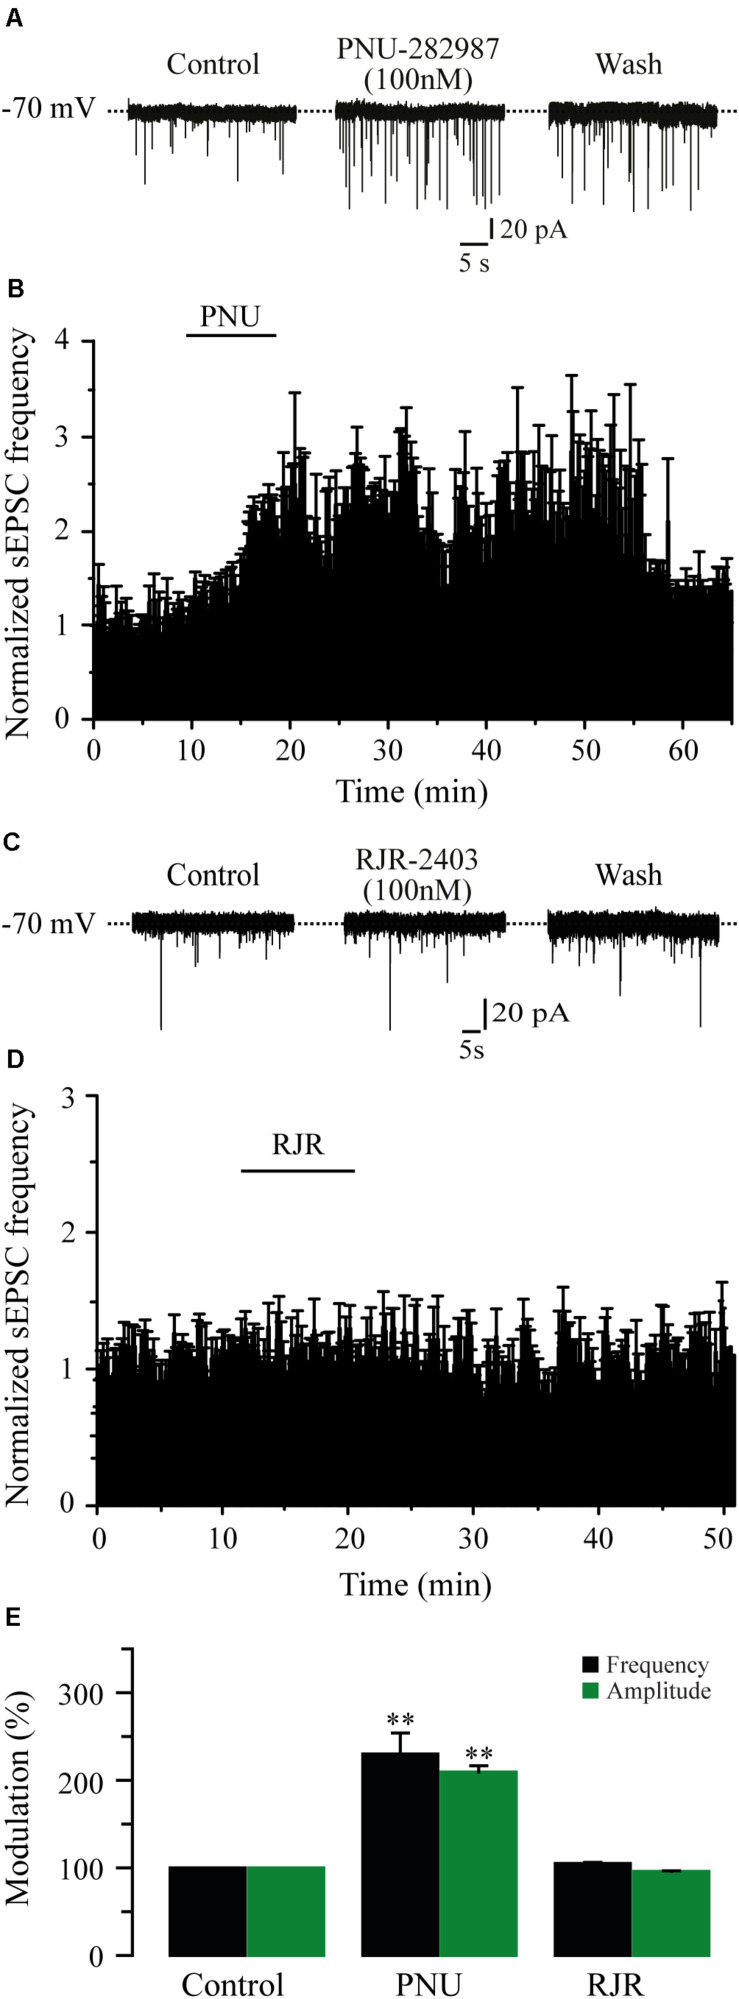
The activation of α7 nAChRs with a selective agonist mimicked the effect of nicotine. (A) Current traces showing sEPSCs in control condition (left), 10 min after the application of PNU-282987, a selective agonist of α7 nAChRs (PNU 100 nM, middle), and 20 min after PNU washout (right). (B) Time-frequency histogram showing the time course of PNU effects (n = 6). (C), Current traces showing sEPSCs in control condition (left), 10 min after the application of RJR-2403, a selective agonist of the α4β2 nAChRs (RJR 100 nM, middle), and 20 min after RJR washout (right). (D) Normalized time-frequency histogram showing the lack of effect of RJR (n = 6). (E) Summary of the data (Mann–Whitney U-test). **p < 0.01.